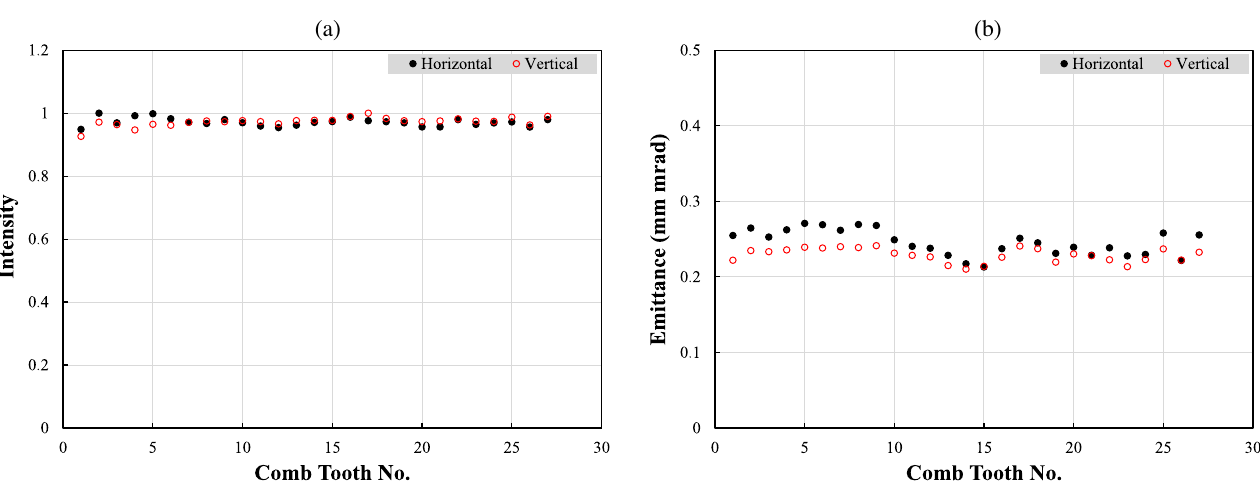
FIG. 11. Calculated beam parameters from the phase space data in Fig. 10. (a) Normalized intensities. (b) Emittance values.